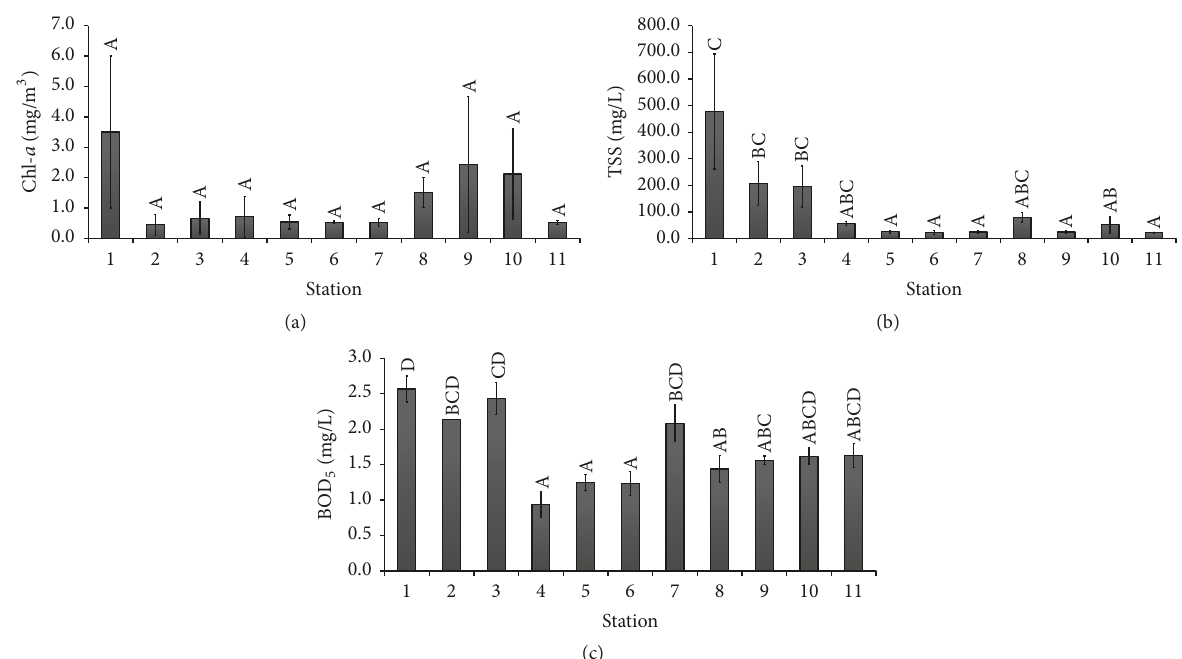
Figure 3: Water quality parameters include (a) Chl- a , (b) TSS, and (c) BOD 5 in coastal near-bottom water column along the coastline of southwestern Sarawak. The same letter indicates no significant difference between the stations ( p value > 0.05).